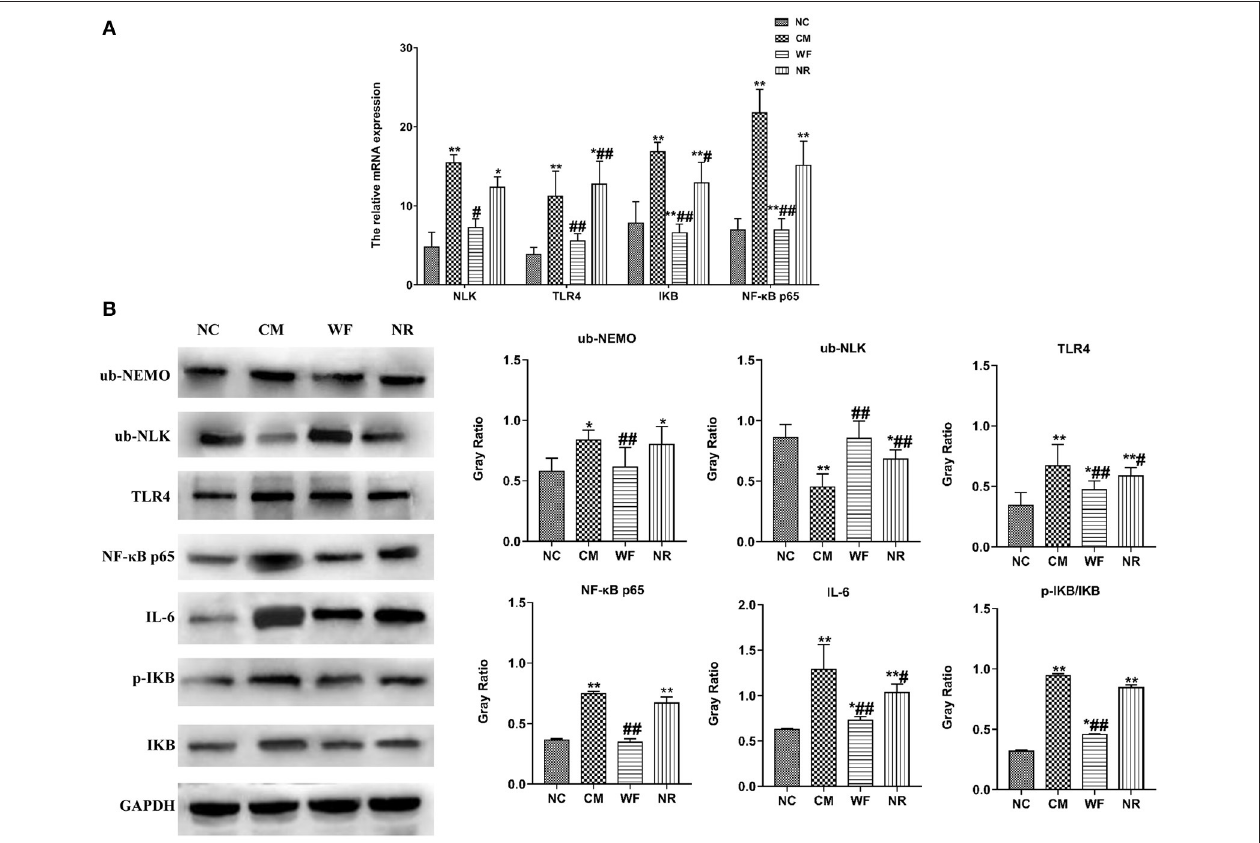
FIGURE 7 | The waterfall forest environment (WF) reduced liver damage by inhibiting the NF- κ B signaling pathway. (A) Effects of the WF on the mRNA expression of NLK, TLR4, IKB, and NF- κ B p65. The relative mRNA expression of NLK, TLR4, IKB, and NF- κ B p65 in the liver tissues was detected by qRT-PCR. (B) Effects of the WF on the protein expression of NF- κ B p65, IL-6, p-IKB, and IKB. The relative protein expression of ub-NEMO, ub-NLK, TLR4, NF- κ B p65, IL-6, p-IKB, and IKB in the liver tissues was detected by western blot. * p < 0.05 and ** p < 0.01 vs. the normal control (NC) group. # p < 0.05 and ## p < 0.01 vs. the chronic stress model (CM)